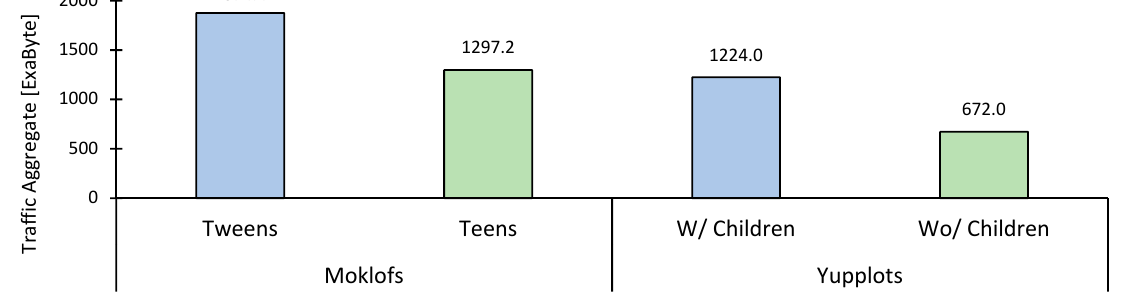
Figure 13. Traffic aggregate for new clustering in a 5 year time span.